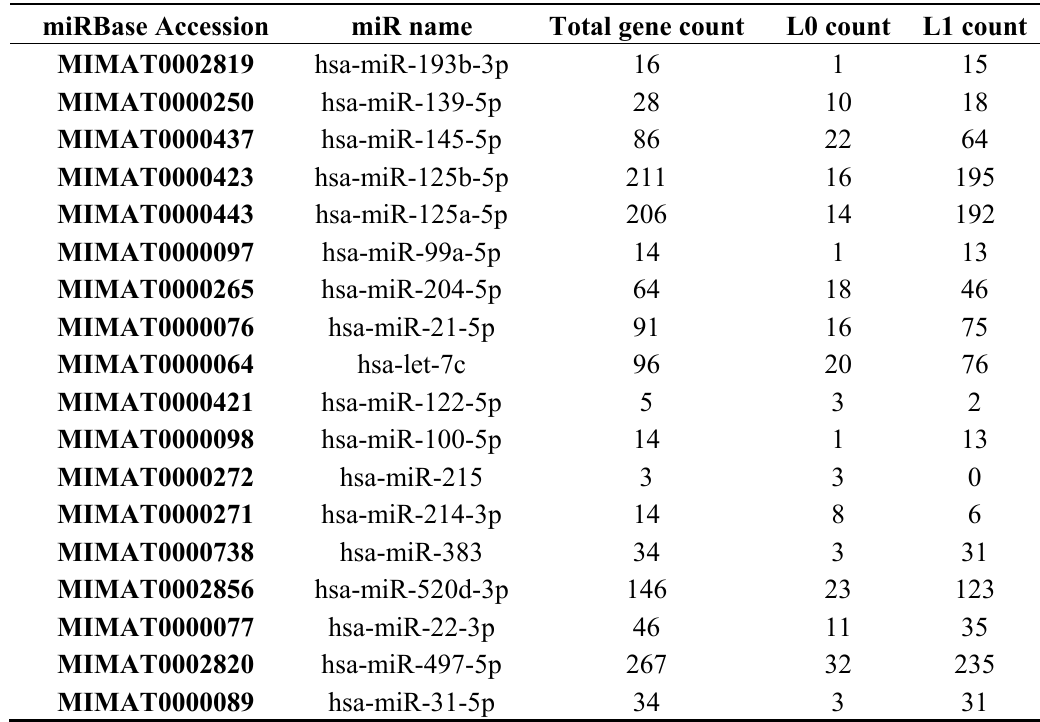
Table S5. Summary of constructed miRNA-regulated networks. L0 gene: genes connected directly to the miRNA ( i.e. , direct target of miRNA); L1 gene: genes not connected directly to the